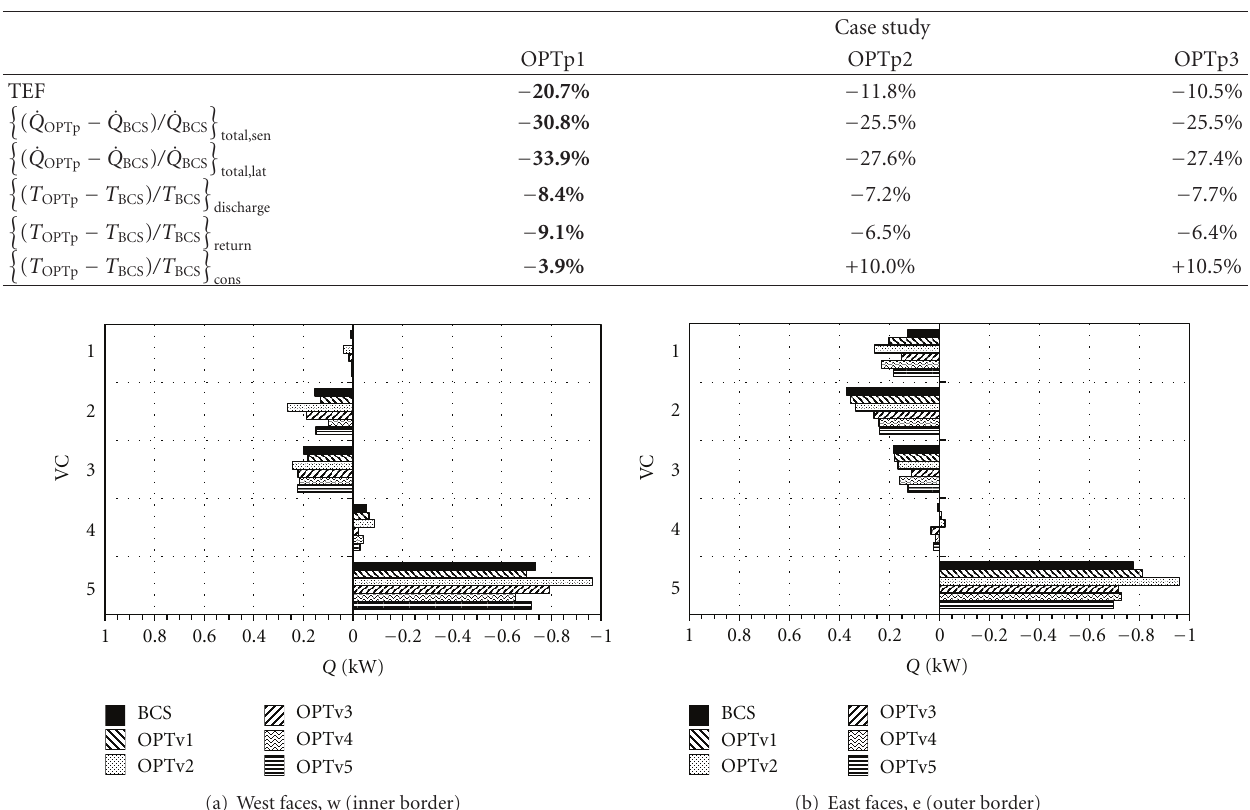
Table 7: Thermal and temperature ratios relatively to BSC—density and distribution perforation parametric study.